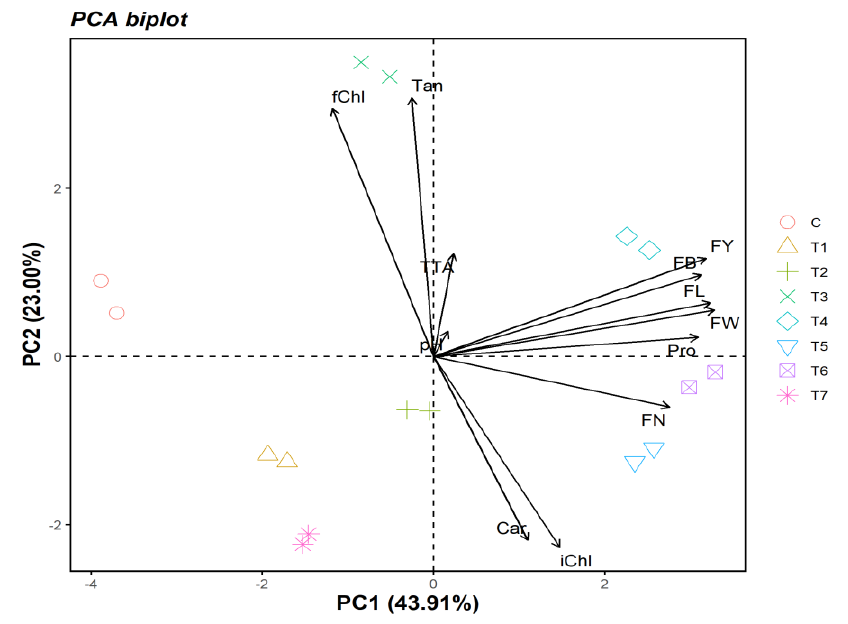
Fig. 3 PCA analysis of field experiment growth parameters of plant (Fruit no per plant- FN; Avg Fruit length (cm)- FL; Avg Fruit breadth (cm)-FB; Avg Fruit weight (gm)-FW; Fruit yield (kg/plant)- F; protein (mg/ml)-Pro; carbohydrates-Car; Total titrable acidity-TTA; pH- pH; Tannin (mg/g)-Tan; Initial chloro- phyll –iChl; Final chlorophyll – fChl)